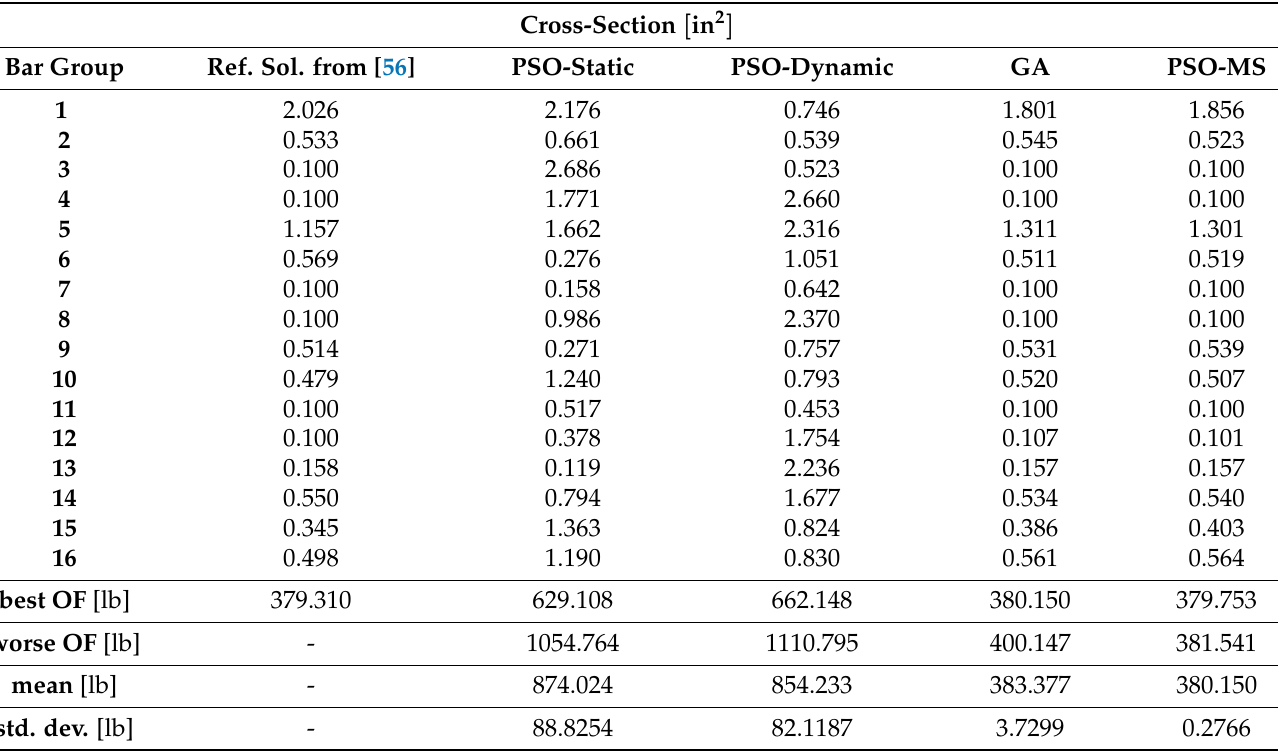
Figure 10. Graphical representation of the four bar groups in which are collected the members inside one module of the seventy-two bars truss design optimization problem. Table 4. Seventy-two bars truss design example: results comparisons for 100 runs among the enhanced multi-strategy PSO ( PSO-MS ), the PSO with static penalty ( PSO-Static ) and the PSO with dynamic penalty ( PSO-Dynamic ) and